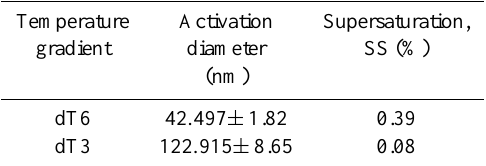
Table 1. Calibration information at varying temperature gradients for NaCl (35gL − 1 ) in